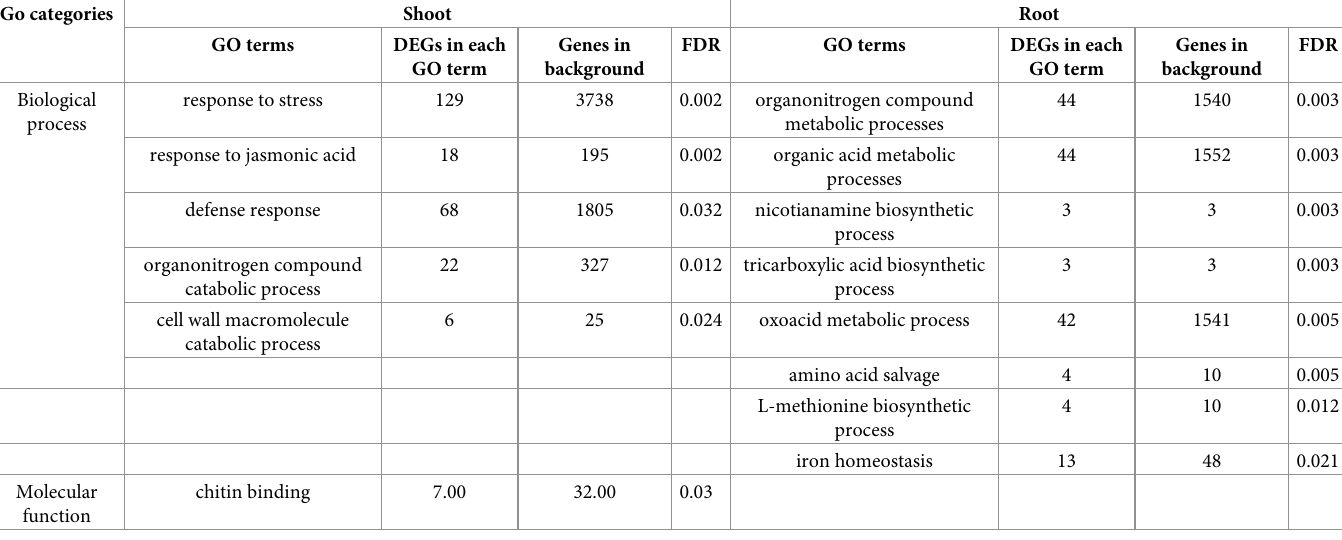
Table 2. Functional category annotations of upregulated genes in both rice genotypes. Go